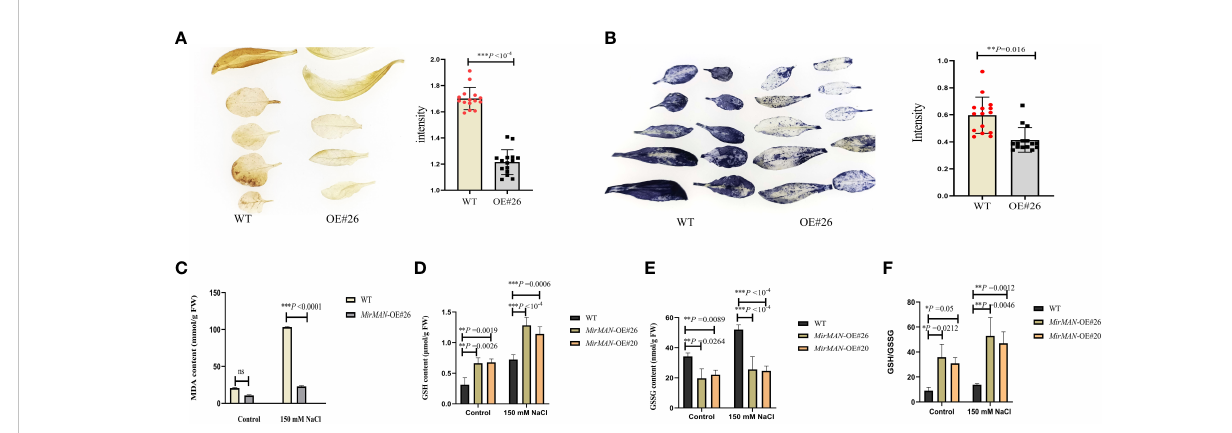
FIGURE 7 Evaluation of salt resistance in WT and OE lines Arabidopsis plants. (A) H 2 O 2 contents. (B) O − 2 contents. (C) MDA contents. (D) GSH contents. (E) GSSG contents. (F) GSH/GSSG. MDA, malondialdehyde; GSH, glutathione; GSSG, oxidized glutathione; WT, wild type. Error bars indicate ± SD. Student ’ s t -tests were used to compare the measurements of OE lines with those from WT. *p< 0.05, **p< 0.01, *** p< 0.001. ns represents no signi fi cance at p >